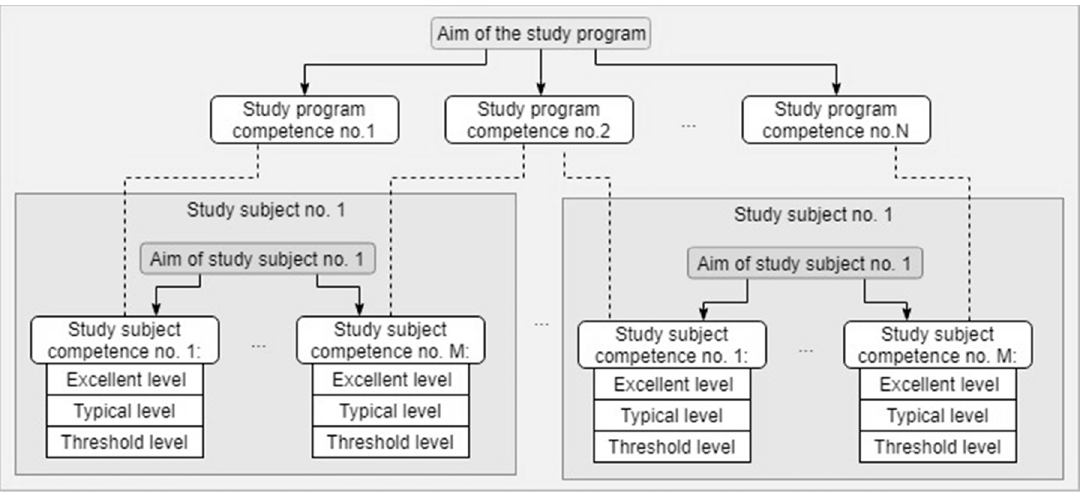
Figure 1. Principle scheme of current study program structure in Lithuania.